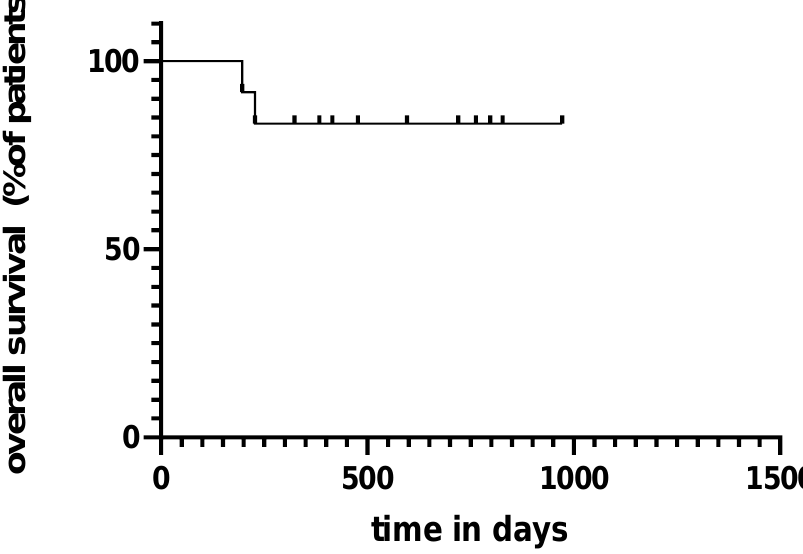
Figure 3. Overall survival of the patients: two patients died within the one-year adjuvant immuno- therapy.